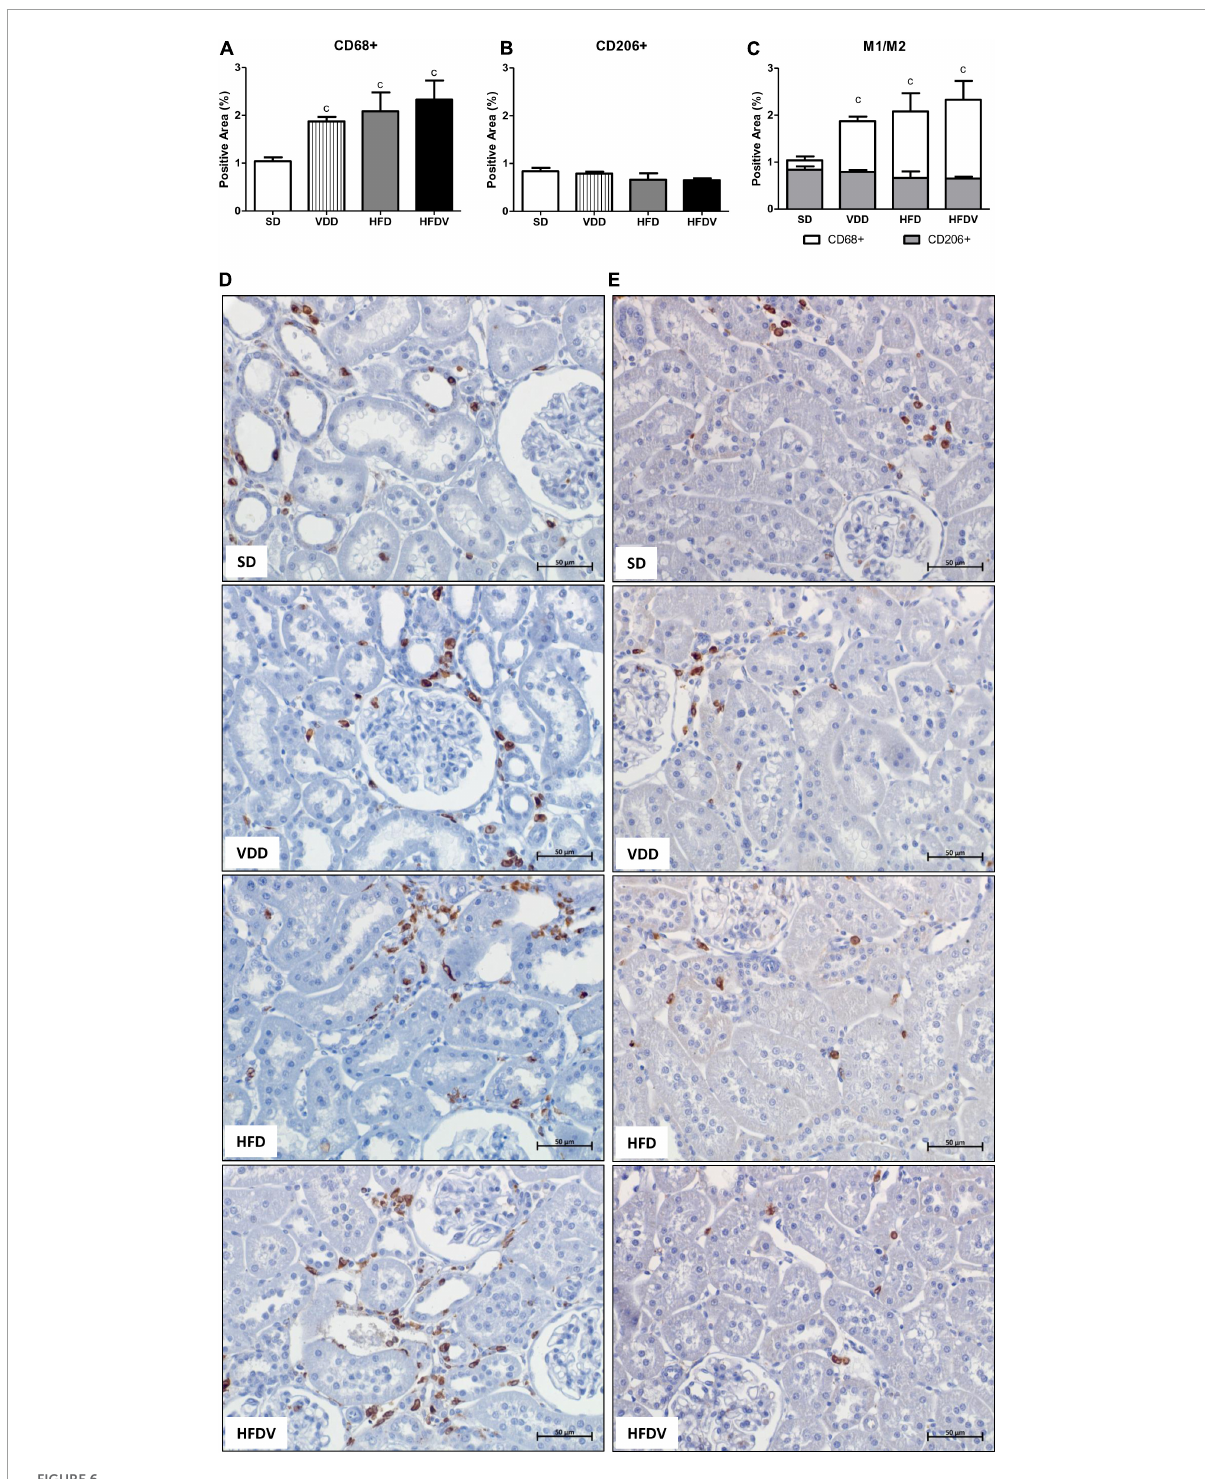
FIGURE6 Immunohistochemical analysis for CD68+ cells (M1 + M2 macrophages) and CD206+ cells (M2 macrophages) expression in the renal cortex evaluated after the 90-day protocol in rats submitted to renal ischemia-reperfusion insult on day 45 treated with standard diet (SD), vitamin D-free diet (VDD), high-fat diet (HFD), or high-fat vitamin D-free diet (HFDV). (A) Bar graph of CD68+ cells expression values. (B) Bar graph of CD206+ cells expression values. (C) Bar graph regarding the proportion of CD206+ cells in relation to the amount of CD68+ cells. Representative photomicrographs of immunostaining for CD68+ (D) and CD206+ (E) cells in the renal cortex from an SD, VDD, HFD, and HFDV rat ( × 400). Data are mean ± SEM. c p < 0.05 vs.